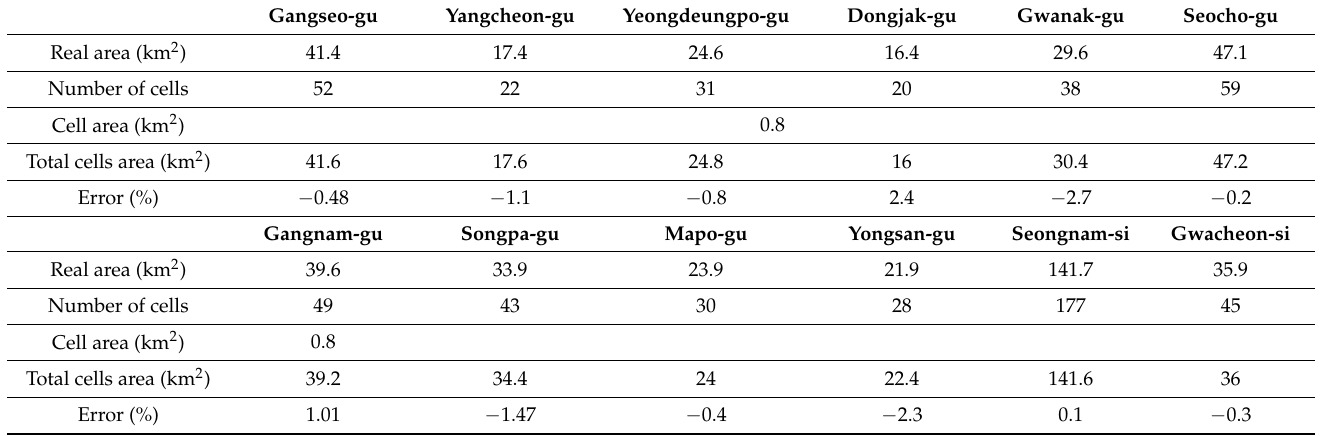
Table 7. Characteristics of virtual space.